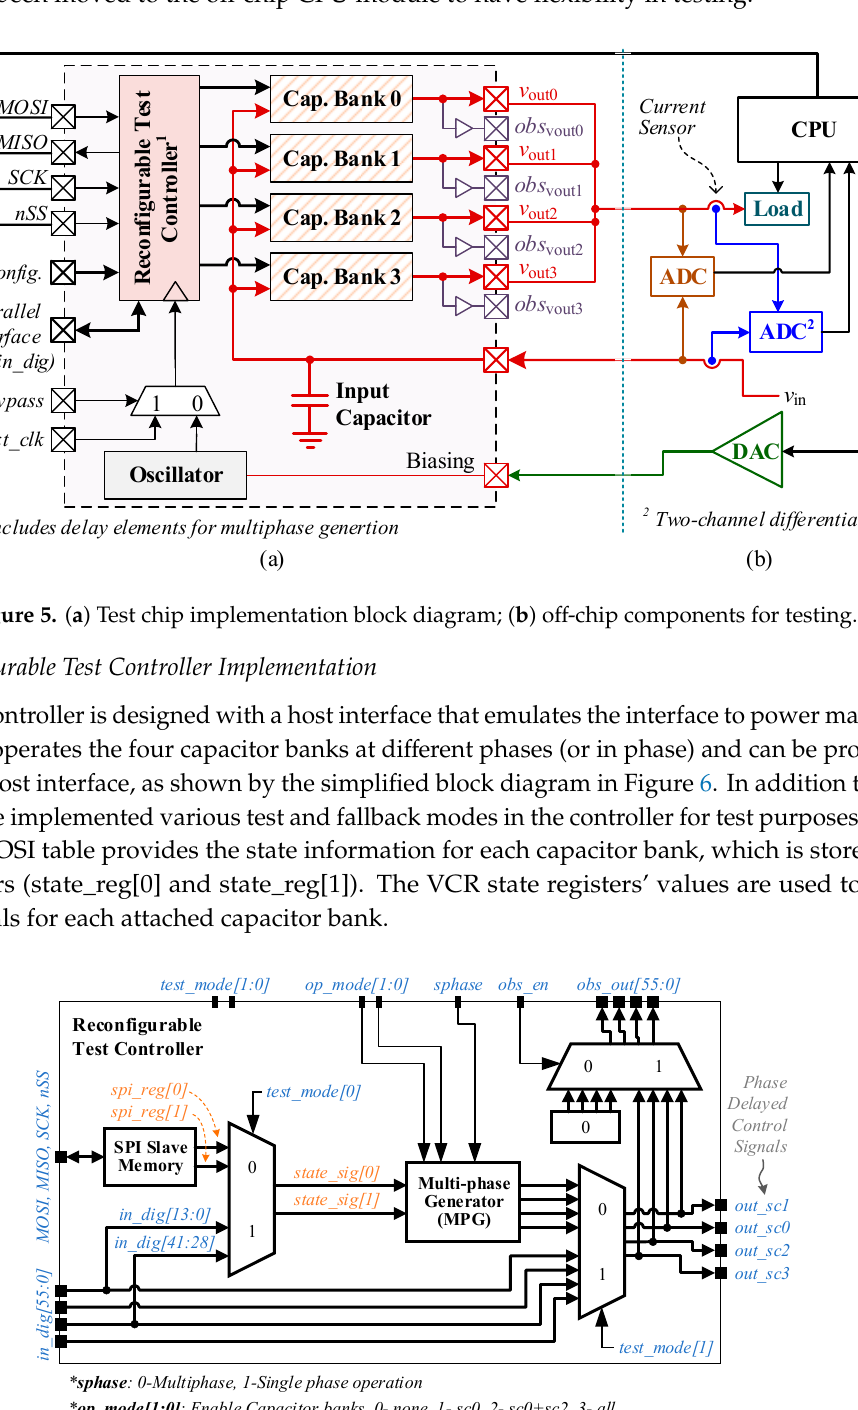
Figure 6. Reconfigurable test controller with interfaces, for a multiphase SC converter.